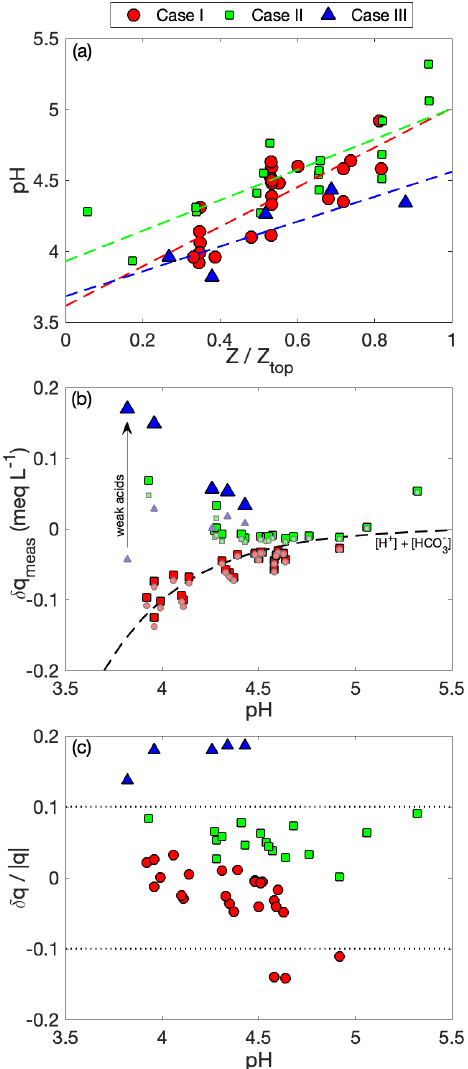
Figure 12. (a) Relationship of CW pH with normalized altitude; (b) pH-charge balance closure analysis: residual charges from mea- sured ions are shown including (solid, large) and discounting (de- saturated, small) weak acid dissociation, with the black dashed line indicating expected charge imbalance at each pH and (c) residual charge from (b) normalized by the total measured charge. The re- gion bounded by the dotted lines indicates a nominal ± 10% zone that is likely indistinguishable from analytical